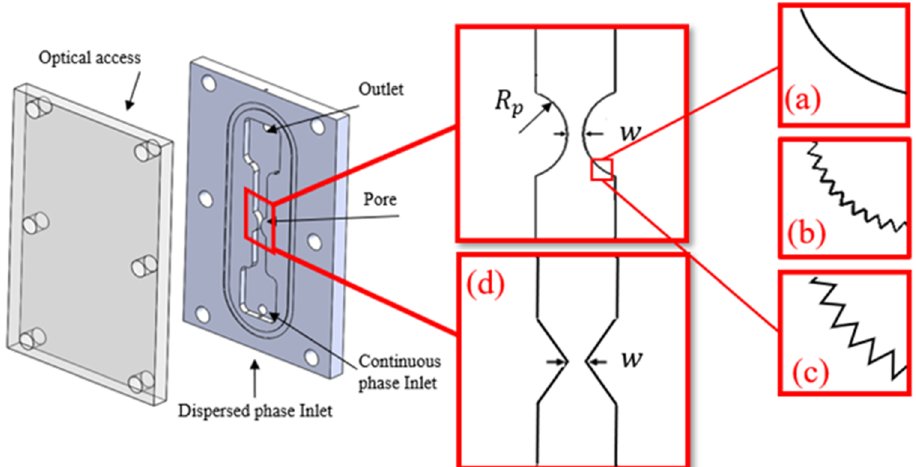
Figure 3. Design of flow channels containing different shapes of pore space ( a ) circular pore ( b ) cir- cular pore with 0.2 mm surface roughness, ( c ) circular pore with 0.4 mm surface roughness, and ( d ) pore with a sharp corner. In the current study, w = 1 mm and R p = 2